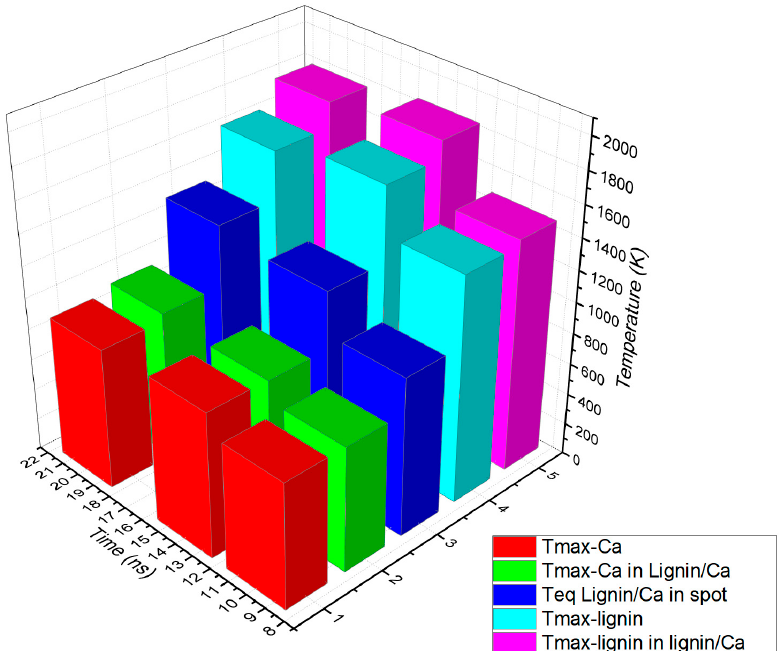
Figure 7. Plot of maximum temperatures achieved due to laser beam absorption and heat diffusion by calcium and lignin (Tmax-Ca and Tmax-lignin) compared to calcium and lignin as components in the lignin/Ca composite (Tmax-Ca in lignin/Ca and Tmax-lignin in lignin/Ca) and at an equilibrium in the spot center of the composite (Teq lignin/Ca in spot).